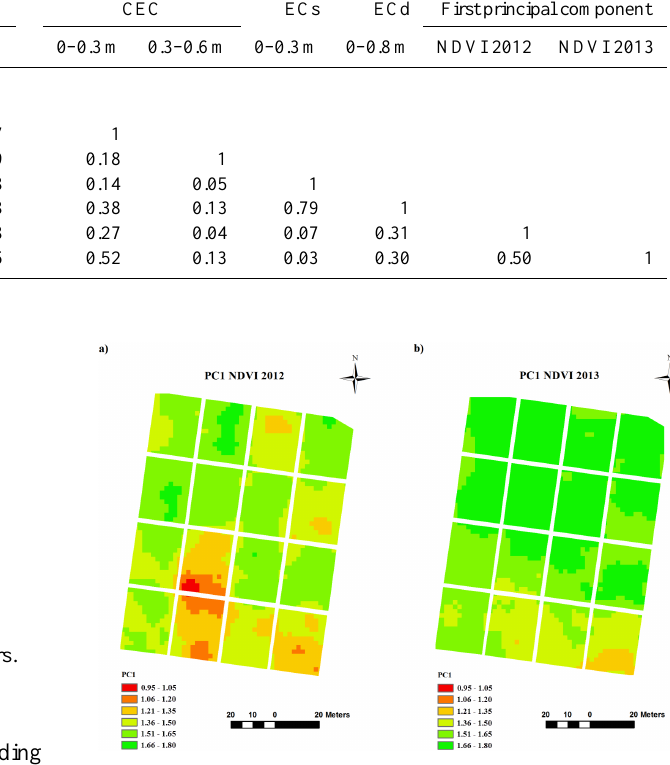
Figure 6. NDVI first principal component of (a) 2012 and (b)